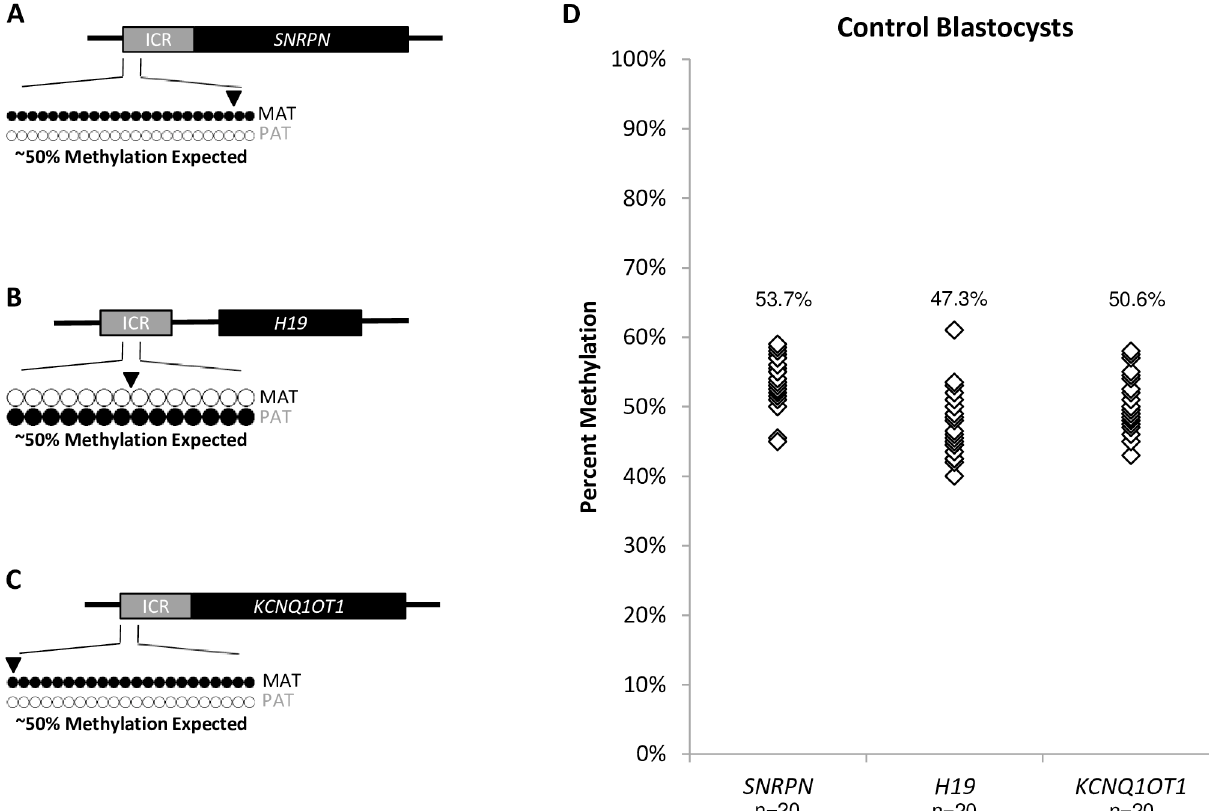
Fig 1. Imprinted DNA methylation profiles of control blastocysts. Black dots represent methylated CpGs, white dots represent unmethylated CpGs. The SNP location is indicated by an arrowhead. “ MAT ” represents the maternal oocyte-contributed allele; “ PAT ” represents the paternal sperm-contributed allele. A) Diagram of the SNRPN ICR amplified region analyzed on human chromosome 15q11.2 (GenBank: U41384) in control blastocysts, a 371 bp region consisting of 24 assessable CpGs and a G/A SNP (Rs220029). The SNRPN ICR is maternally methylated. Approximately 50% methylation is expected, derived from one MAT allele and one PAT allele. B) Diagram of the H19 ICR amplified region analyzed on human chromosome 11p15.5 (GenBank: AF087017) in control blastocysts, a 170 bp region consisting of 14 assessable CpGs and a A/C SNP (Rs2071094). The H19 ICR is paternally methylated. Approximately 50% methylation is expected, derived from one MAT allele and one PAT allele. C) Diagram of the KCNQ1OT1 ICR amplified region analyzed on human chromosome 11p15.5 (GenBank: U90095) in control blastocysts, a 265 bp region consisting of 22 assessable CpGs and a G/A SNP (Rs56134313). The KCNQ1OT1 ICR is maternally methylated. Approximately 50% methylation is expected, derived from one MAT allele and one PAT allele. D) Summary chart of percent methylation in all control blastocysts at the SNRPN (n = 20), H19 (n = 20), and KCNQ1OT1 (n = 20) ICRs. Each white diamond represents the methylation percentage for one individual control blastocyst per ICR. Average percent methylation for each cohort is indicated above each gene. Methylation dot diagrams for individual control blastocysts can be found in S1 Fig, and a summary can be found in S2 Table.